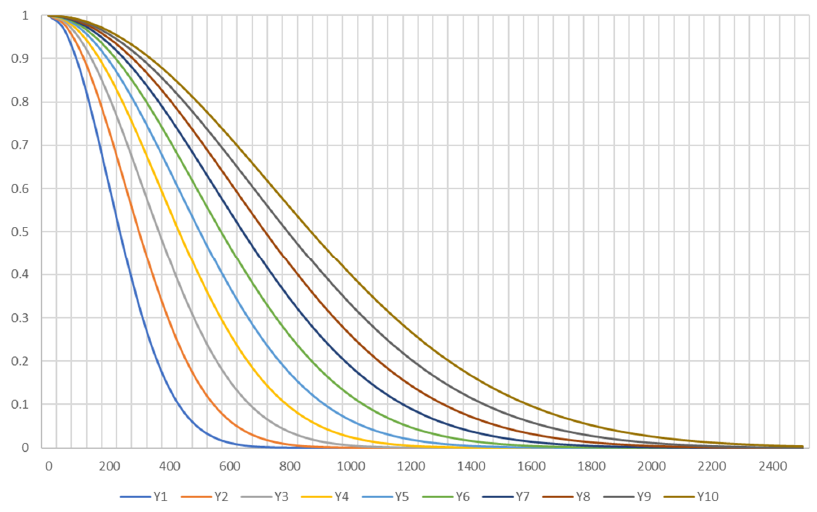
Figure 16. Distance-decay functions for 10 tested combinations of β and walking speed.